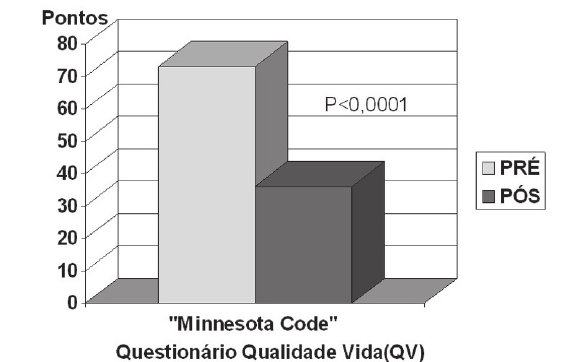
Fig. 1 - Comportamento da avaliação da qualidade de vida pelo Minnesota Code, em pacientes com insuficiência cardíaca avançada submetidos a implante de ressincronizador ventricular